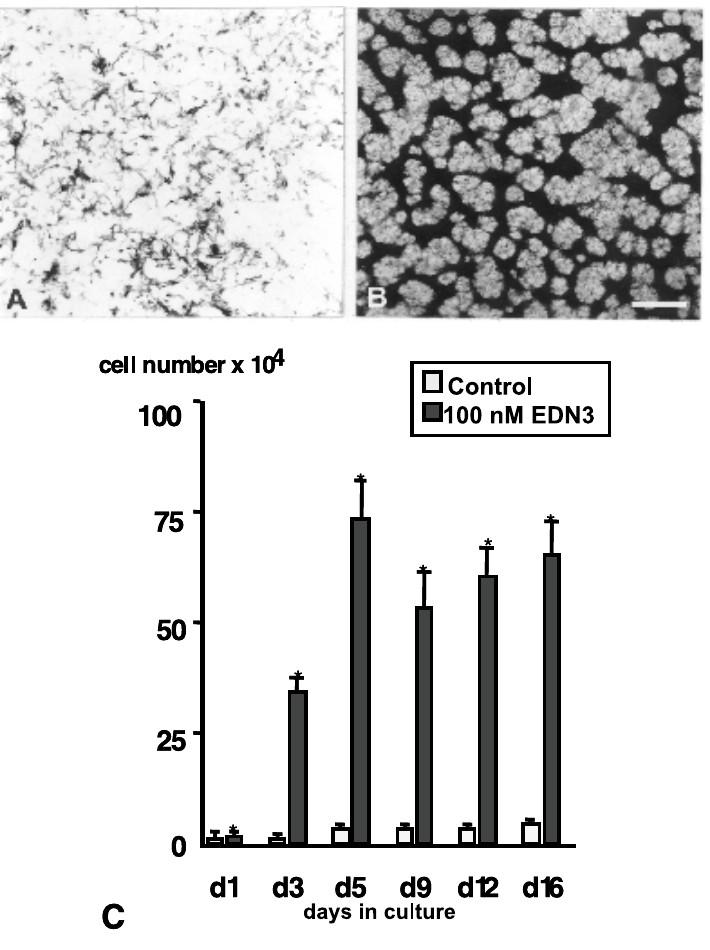
Fig. 3–EffectsofEDN3onmelanogenesisandcelldivisionbyquailNCcells invitro . (A, B) Effect of EDN3 on the pigmentation by trunk NC cells after 11 days in culture. Incontrolmedium(A),melanocytesremaindispersedwhereasEDN3-treatedcultures (B) show reproducible pattern of pigment cells and unpigmented pre-melanocytes. (C) Quantification of EDN3-induced changes of the total cell number at different time points. Cultures of quail trunk NC cells were analyzed during a culture period of 16 days. Significant differences are indicated by a star at the top of columns. (From Lahav et al.